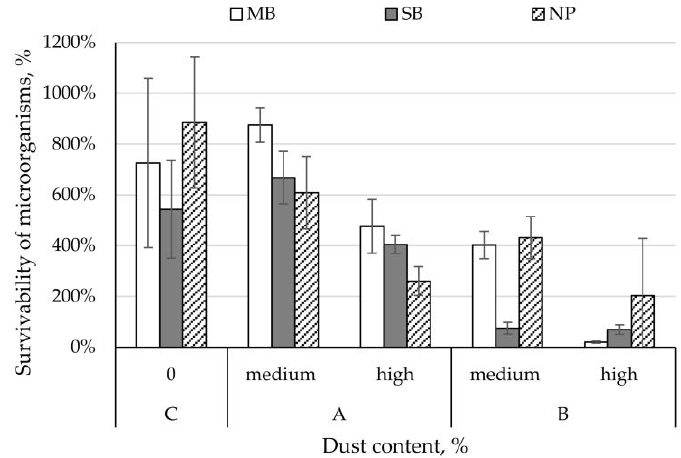
Figure 3. Survivability of Candida albicans yeasts on filtering nonwovens depending on dust-type and content.